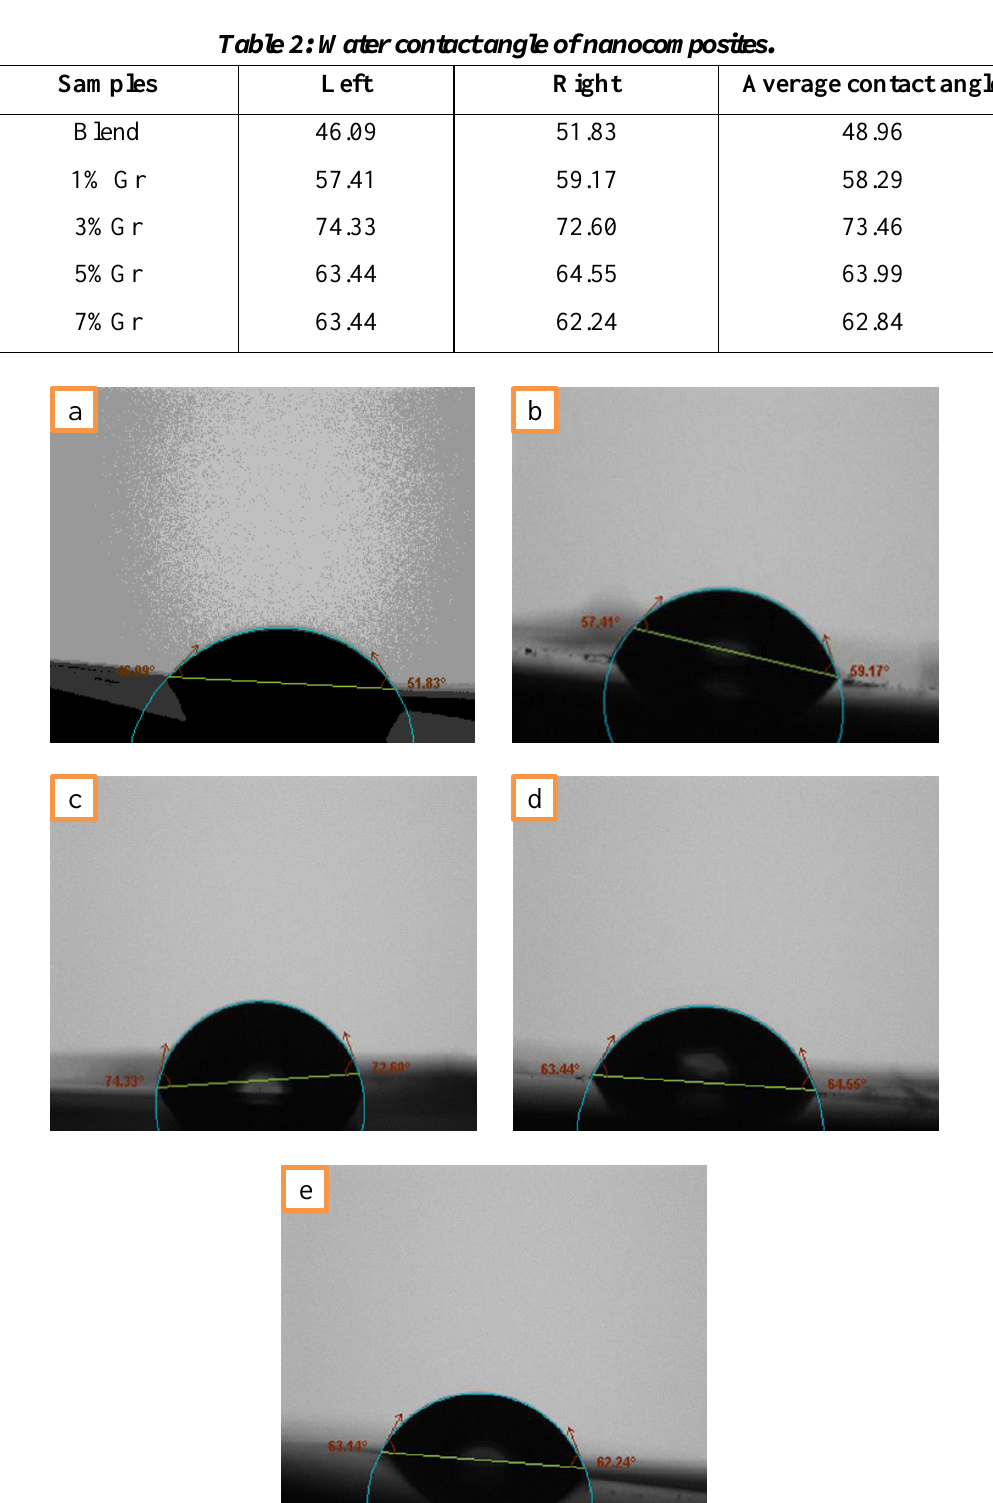
Figure 4: Contact angle for: (a) blend (Eboxy resin and Repcoat ZR), (b)1%wt